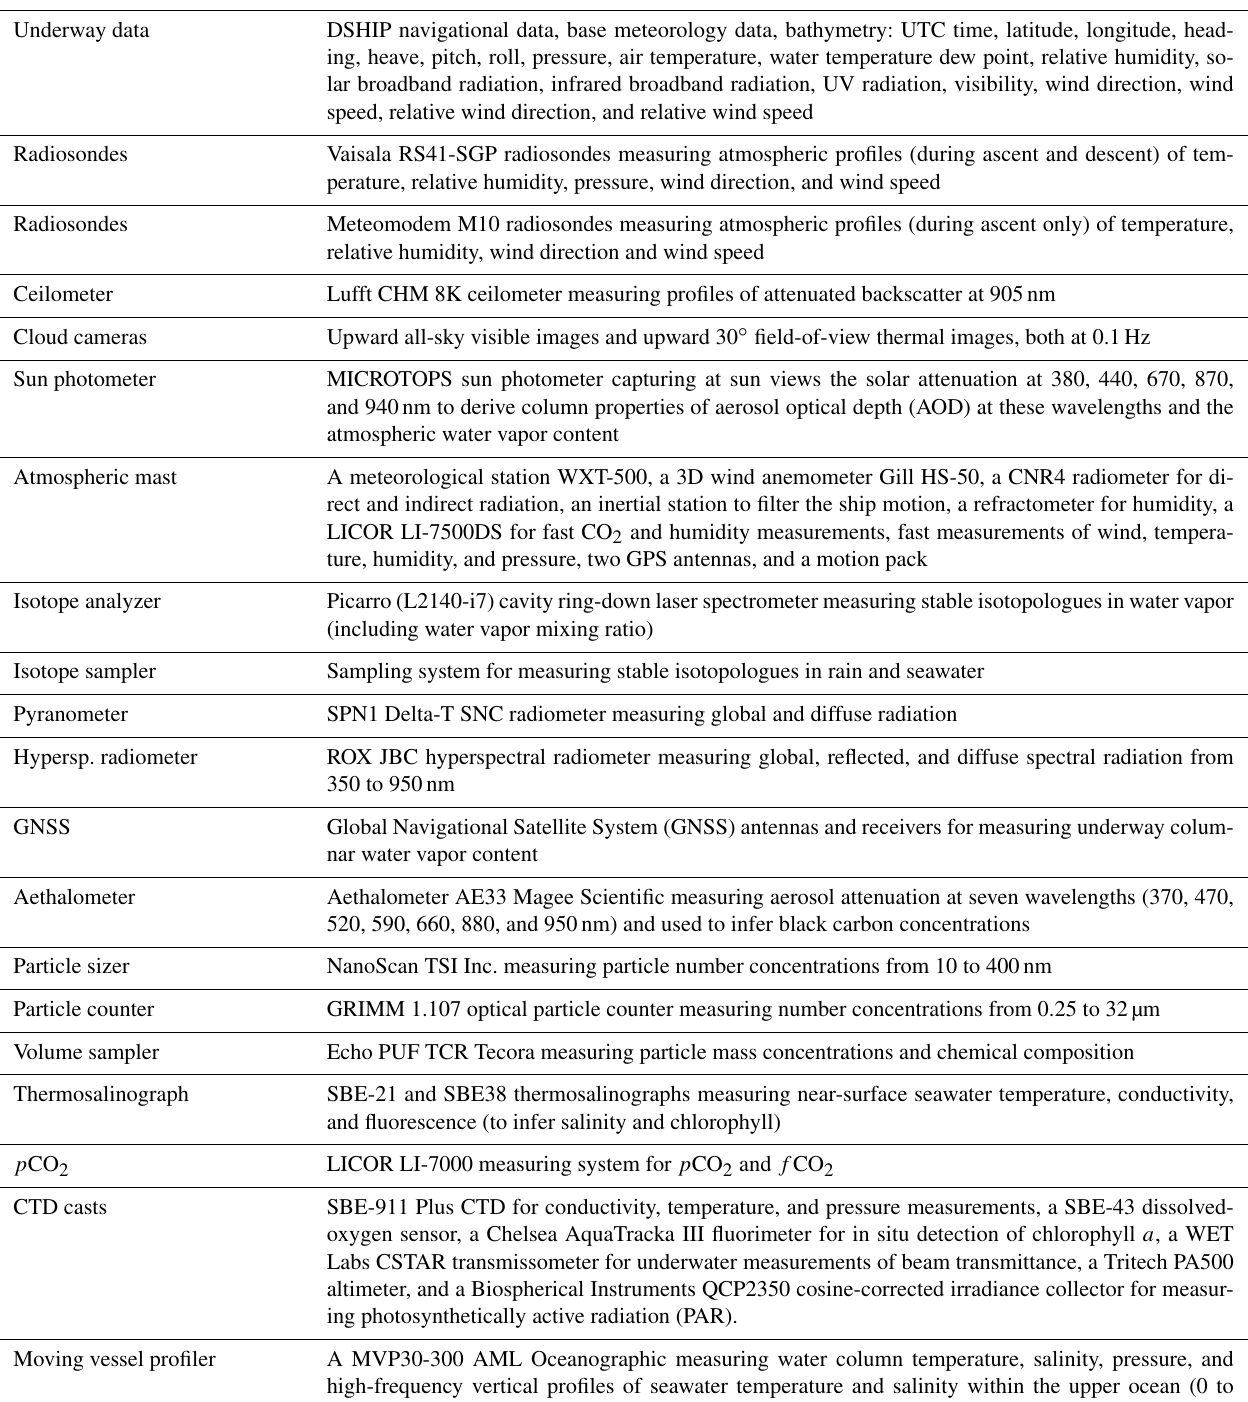
Table B7. Atalante .